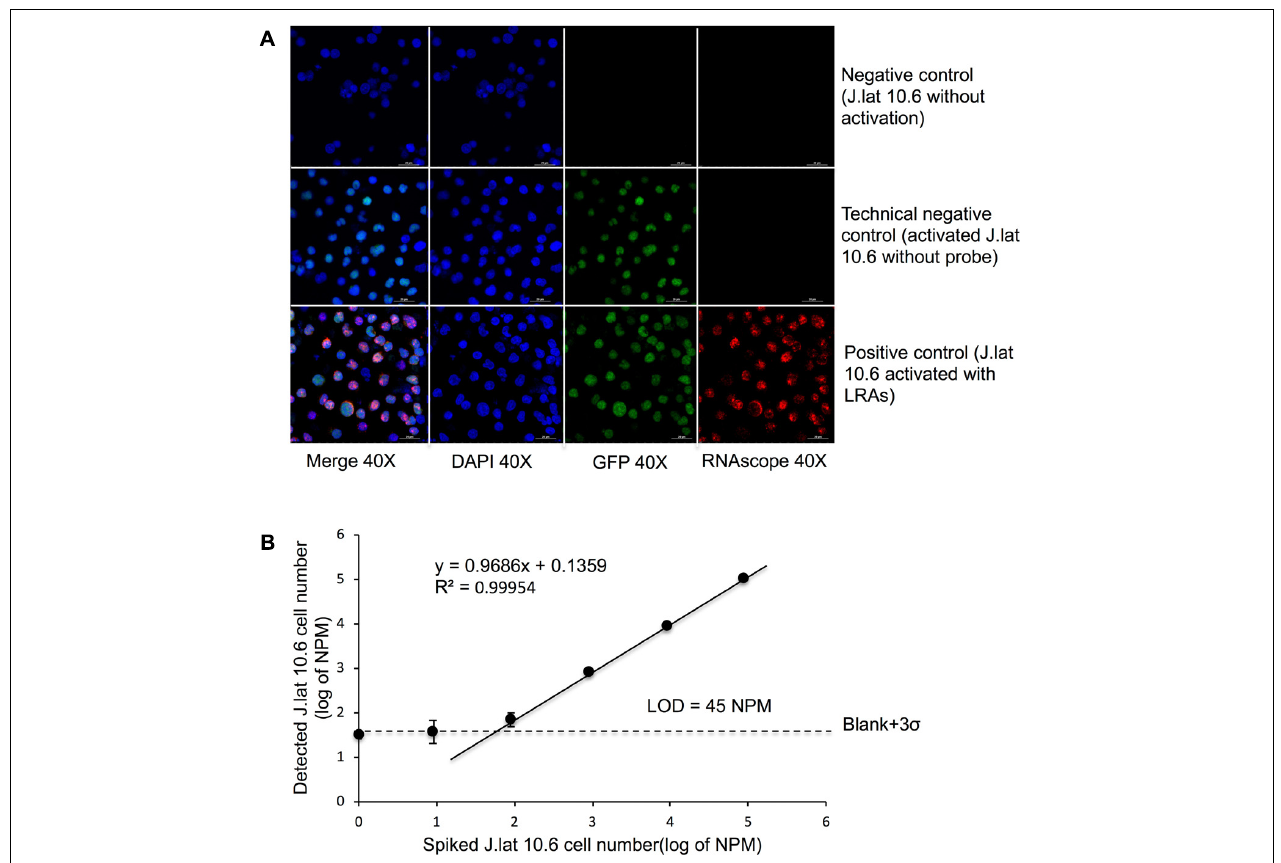
FIGURE 4 | Automated counting strategy and the lower detection limit of RNAscope (A) Detection of rare cells by microscopy following RNAscope HIV mRNA + / GFP + , HIV mRNA + and HIV GFP + cells were detected after LRA stimulation using confocal microscopy with a series (as mentioned in Figure 3 ) of activated J-Lat 10.6 cells in the parental Jurkat cell line (B) LOD was measured by automatic cell counting and analysis for dual recognition of HIV mRNA + / GFP + using the same formula mentioned in Figure 3 . Automated counting detected all mRNA signal related to cells that have an active transcription of GFP, and correlates it to the proportion of all detected nuclei